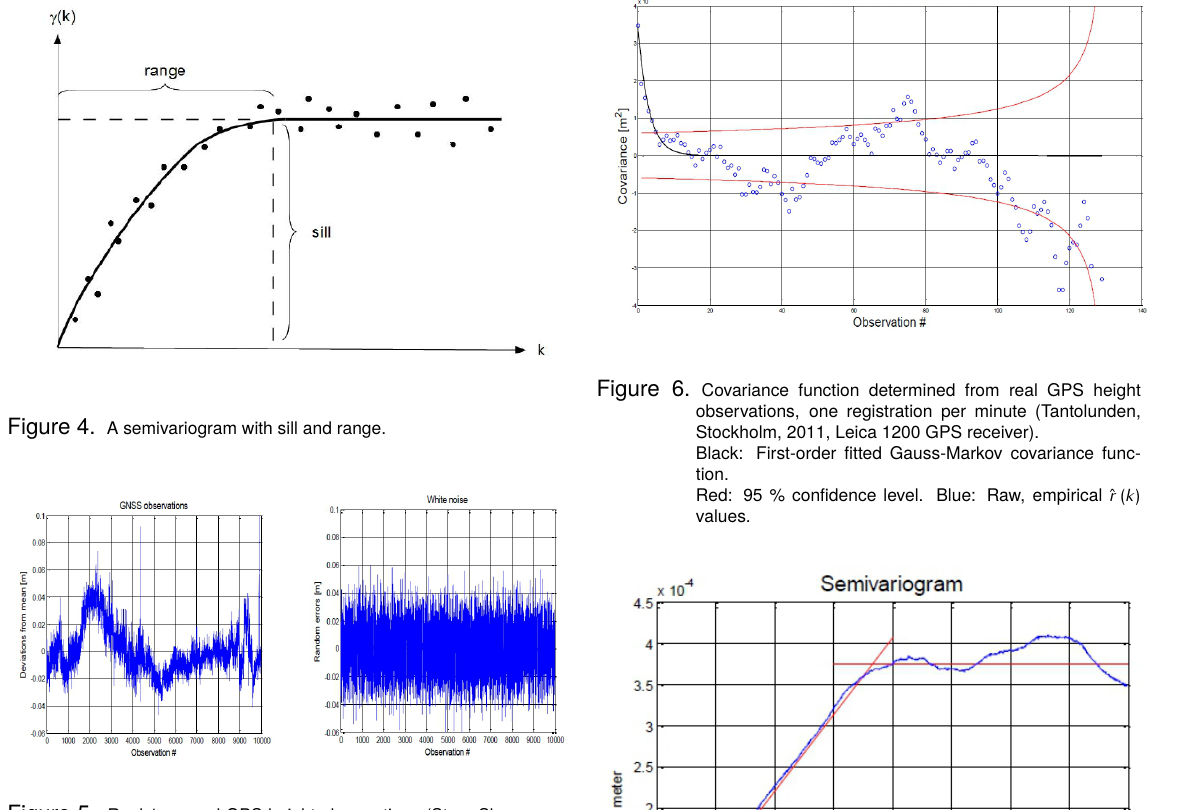
Figure 5. Real 1-second GPS height observations (Stora Skuggan, Stockholm, 2011, Leica1200 GPSreceiver)(left) vs. white noise (simulated, uncorrelated, normally distributed ran- domerrors, withthesamevarianceastherealdata)(right).